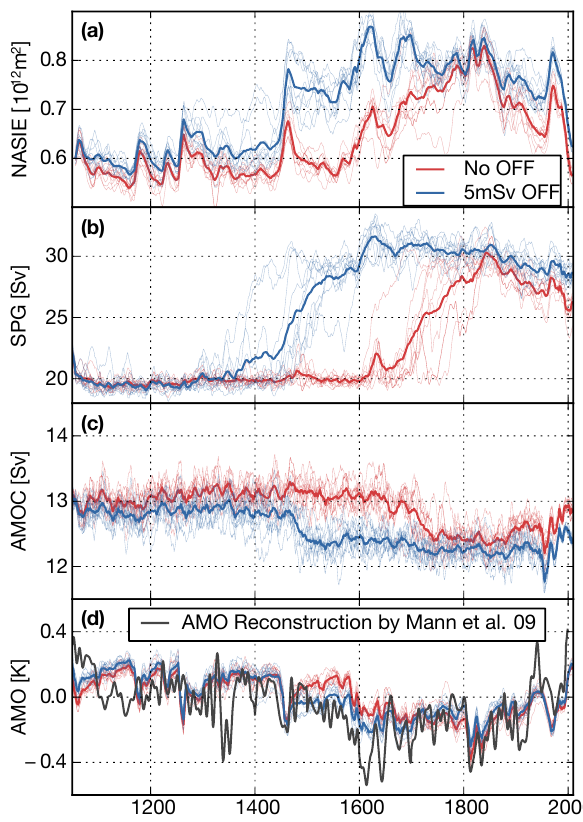
Fig. 2. Transient model results of the last millennium with pre- scribed TSI, CO 2 and wind-stress forcing applied. (a) The North Atlantic Sea-Ice Extent (NASIE) for an ensemble with an additional 5mSv freshwater offset in the Nordic seas (blue) and without fresh- water offset (red, individual ensemble members in light red, thick lines: ensemble mean). (b) Depicts the SPG dynamics and (c) the AMOC at 30N. (d) AMO anomalies in comparison with the recon- structed AMO index by Mann et al. (2009).